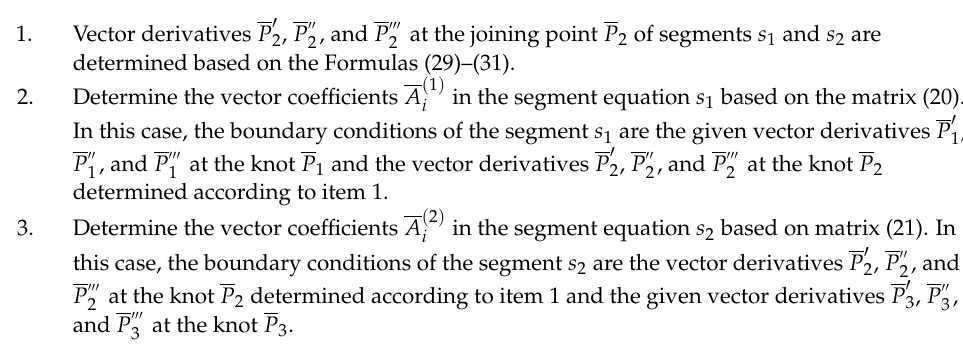
Figure 14. Initial data and the result of connection of three segments of a seventh-degree Hermite spline curve. Algorithm 2 For obtaining a spline curve with polynomial equations of the seventh degree of segments s 1 and s 2 has the following text form: